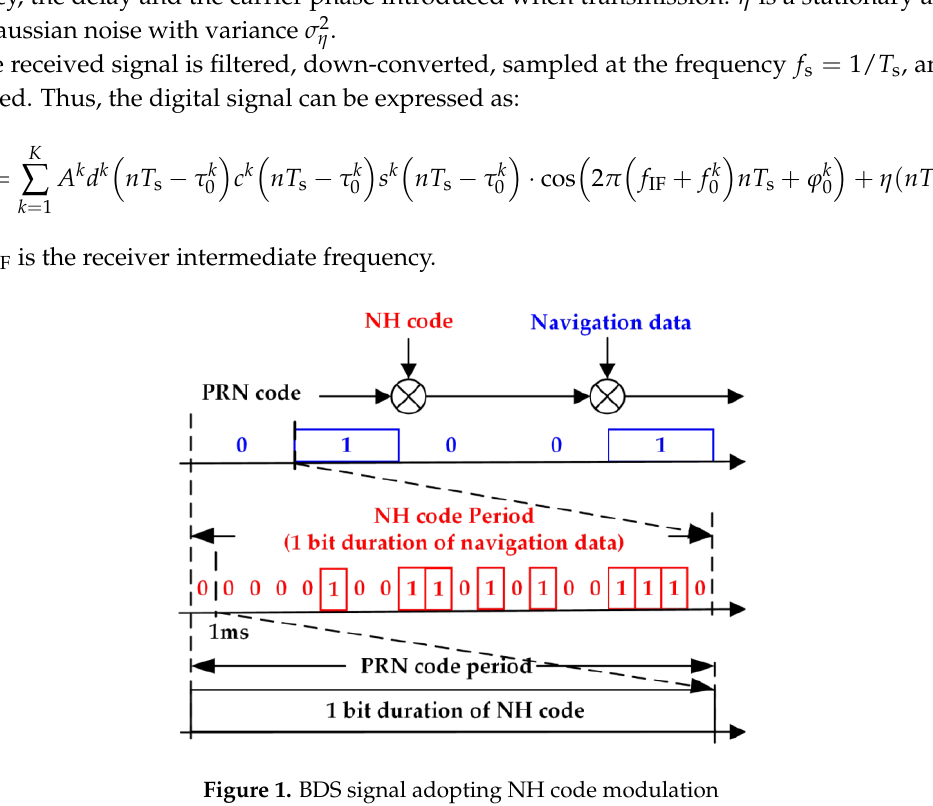
Figure 1. BDS signal adopting NH code modulation